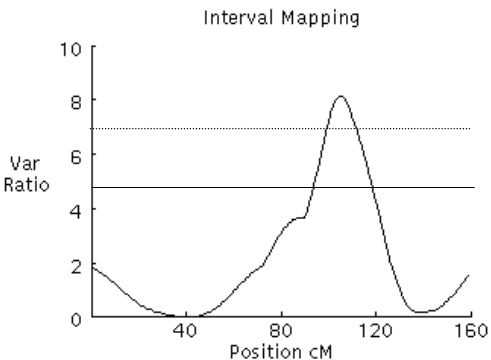
Figure 4. F-ratio curves for intramuscular fat on chromosome 8. The x-axis indicates the relative position on the linkage map. The y-axis represents the F-ratio. The horizontal line indicates the 5% chromosome-wide significance level from the permutation